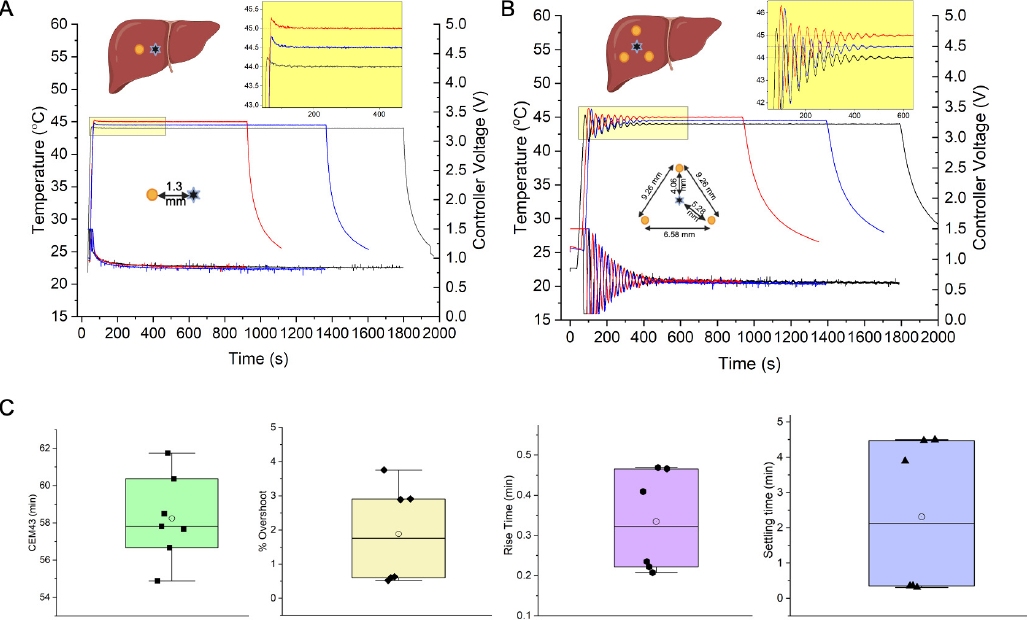
Figure 3. Temperature-controller performance during ex vivo heating experiments in a cow liver lobe, with single standard Cu wire heat source, ( A ), and a 3-wire distributed heat source configuration, ( B ). Yellow circle ( ● ) in the liver schematic indicates a Cu wire cross-section, and a star symbol ( ✶ ) indicates fiberoptic temperature probe sensor placement. ( A ) Temperature vs. time (left y -axis), and controller voltage vs. time (right y -axis), responses of the PID controller to setpoint temperatures T ref of 44, 44.5 and 45 ◦ C for treatment times of 30, 22.5 and 15 min, respectively in a cow liver lobe with a single Cu wire heat source. The probe sensor distance from the Cu heat source was 1.5 mm ( ± 10%). Treatment times were chosen to cover a range of 15–30 min, based on clinical safety requirements (e/g. canine patient time under anesthesia <30 min) for MHT treatments. Based on the selected treatment time (15, 22.5 or 30 min), the setpoint temperatures were accordingly adjusted to achieve a target CEM43 of 60 min, i.e., 44 ◦ C for 30 min, 44.5 ◦ C for 22.5 min and 45 ◦ C for 15 min. Three experiments were conducted for the single heat source geometry (N = 3). Within each experiment, a different target temperature setpoint was selected (44 ◦ C for 30 min, 44.5 ◦ C for 22.5 min and 45 ◦ C for 15 min). Inset shows magnified view of the temperature overshoot (<1%) and steady (cid:0) (cid:1) K p , K i , K d state error (<1%). gains of (0.2, 1 × 10 − 5 , 2.5) were used. ( B ) Temperature vs. time (left y -axis), and controller voltage vs. time (right y -axis), responses of the PID controller to setpoint temperatures T ref of 44, 44.5 and 45 ◦ C for treatment times of 30, 22.5 and 15 min, respectively in a cow liver lobe with three distributed Cu wire heat sources. The probe sensor is placed within the triangle formed from the Cu wire cross-sections. Distances between Cu wires and between Cu wire and temperature sensor are given in the inset. Treatment times were chosen to cover a range of 15–30 min, based on clinical safety requirements (e.g., canine patient time under anesthesia <30 min) for MHT treatments. Based on the selected treatment time (15, 22.5 or 30 min), the setpoint temperatures were and 45 ◦ C for15 min. Three experiments were conducted for the distributed heat source geometry (N = 3). Within each experiment, a different target temperature setpoint was selected (44 ◦ C for 30 min, 44.5 ◦ C for 22.5 min and 45 ◦ C for 15 min). Inset shows magnified view of the temperature overshoot (<5%) and steady state error (<1%). ( K p , K i , K d ) gains of (0.5, 1 × 10 − 6 , 2.5) were used. ( C ) Box-whisker + scatter plot of controller performance parameters obtained from temperature